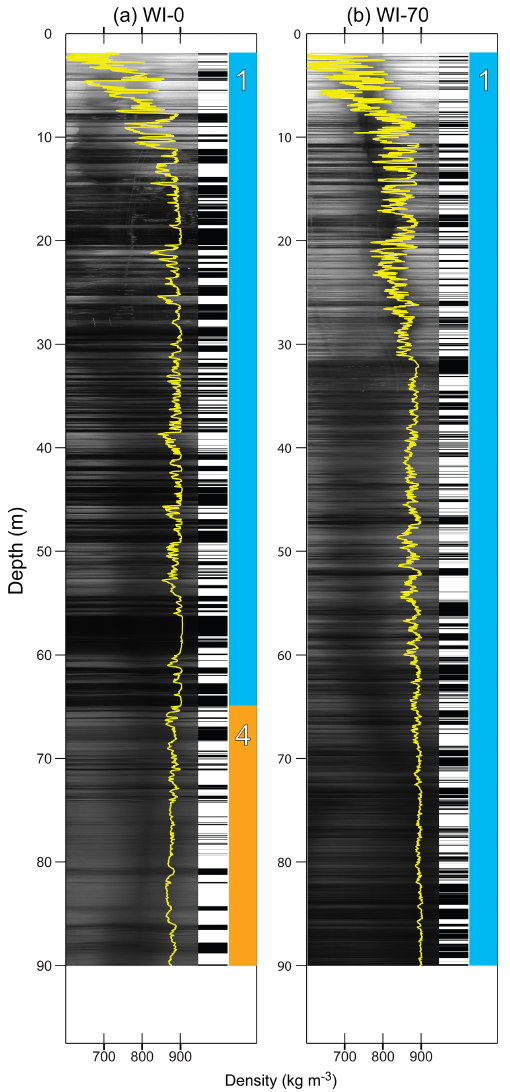
Figure 3. OPTV images, density profiles, unit classifications, and binary thresholding output for boreholes at (a) WI-0 and (b) WI- 22. See Fig. 2 caption for more